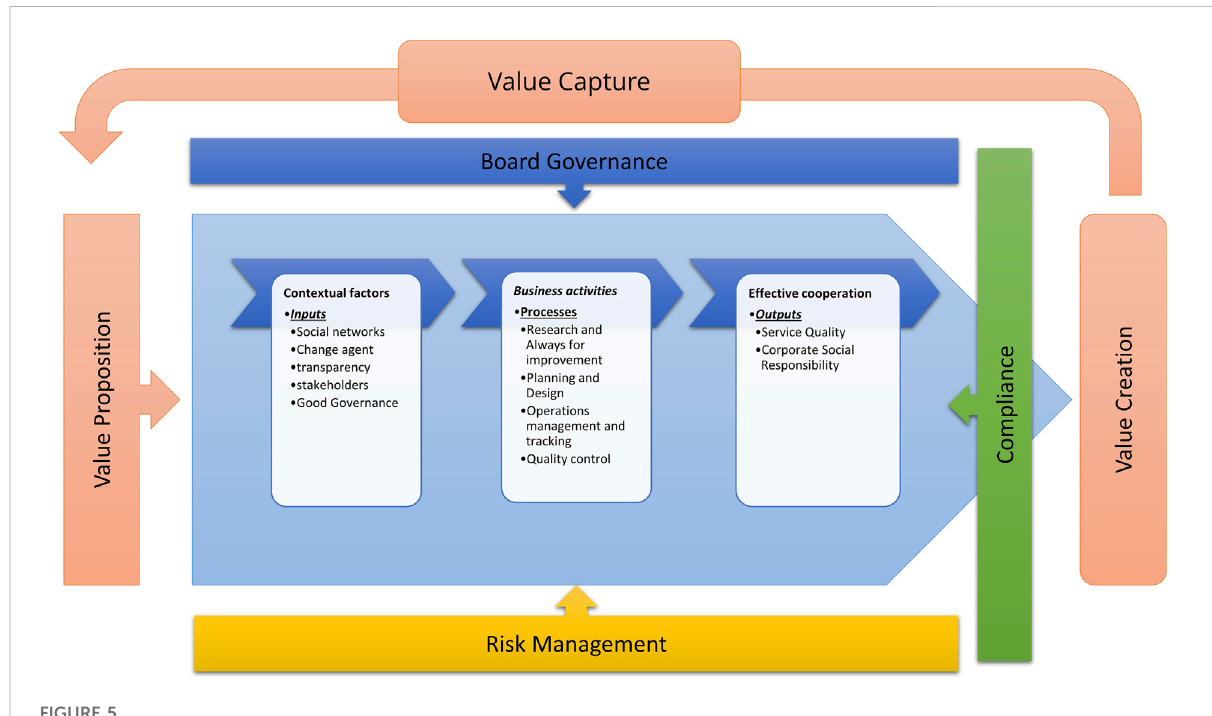
FIGURE 5 Proposed framework: A Sustainable Business Framework for Community Water Supply